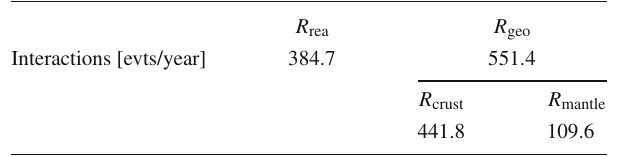
Table 5 Antineutrino interaction rates in one year in the full Theia